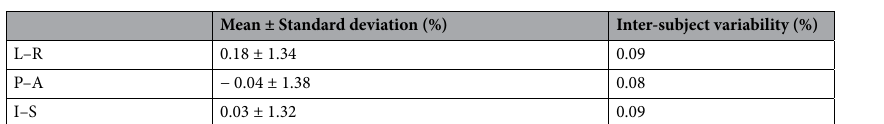
Mean ± Standard deviation